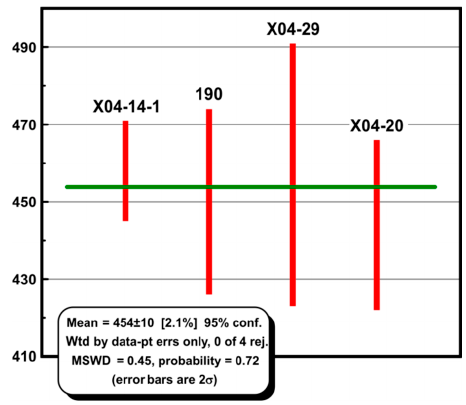
Figure 12. Weighted average of the available U-Pb baddeleyite dates of Ordovician mafic intrusions, to estimate the age of the Suordakh event.